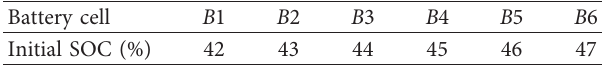
Table 2: The initial SOCs of the six battery cells. Battery